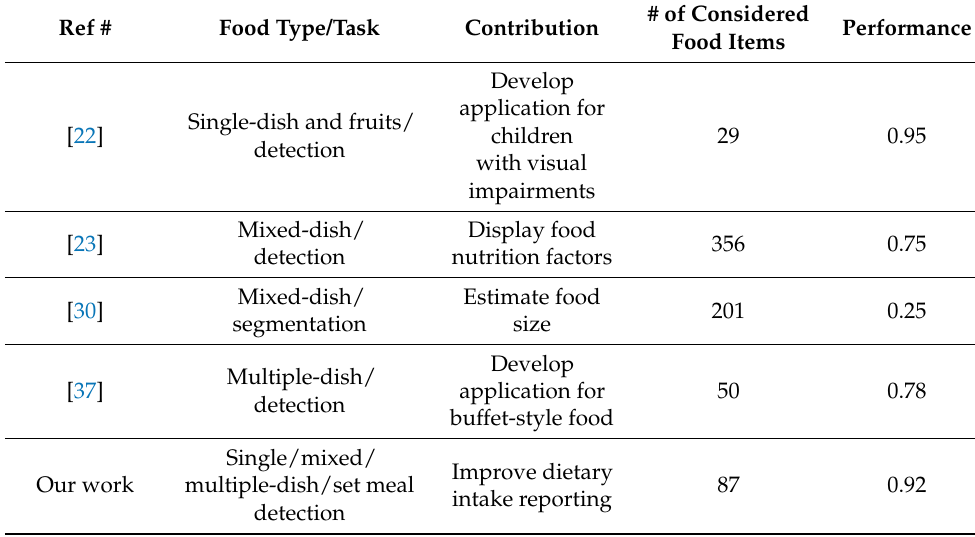
Table 1. Summary of related works’